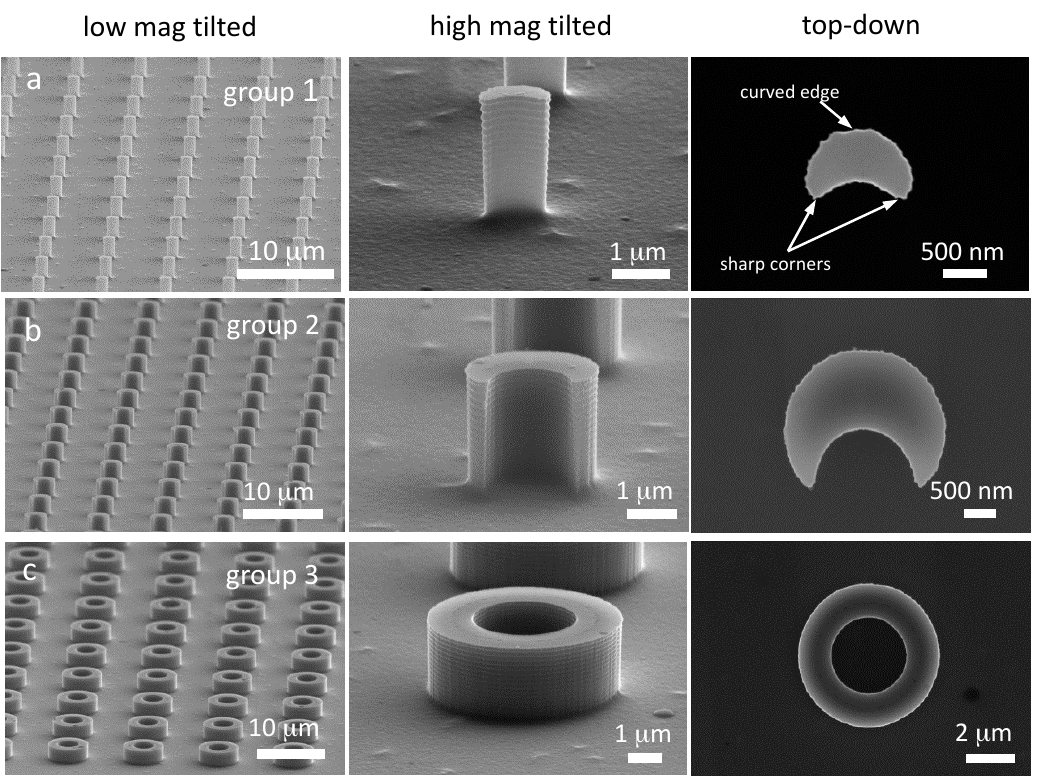
Figure 2. SEM micrographs of silicon pillars with complex cross-sectional geometries examined in this work: ( a ) group 1, small C-shaped pillars; ( b ) group 2, large C-shaped pillars; and ( c ) group 3, hollow pillars. Table 1. Physical dimensions of micron and sub-micron scale silicon pillars. Statistical distributions of PC3 cells that show fine line features after incubation on silicon substrates with various pillar geometries for approximately 72 h. Data spreads correspond to one standard error.